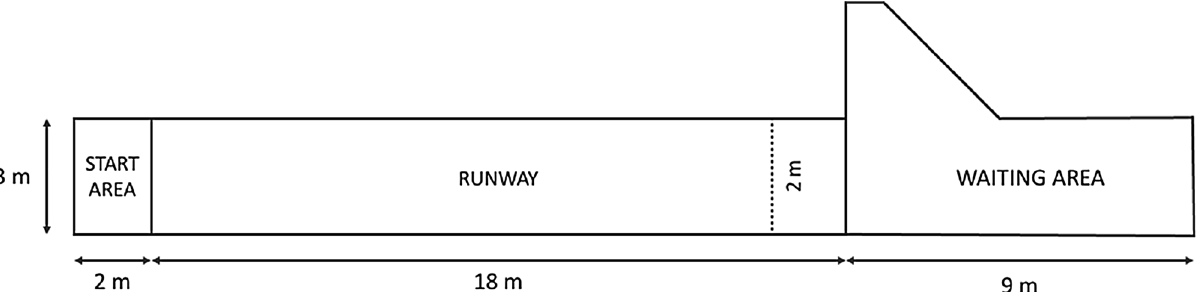
Figure 3. Layout of the runway. During the test, five cows were herded in the waiting area, and the focal heifer was brought by one experimenter to the start area. After 1 min, the heifer was released onto the runway for 5 min. A second experimenter scored the heifer’s time spent within 2 m (dashed line) from the gate separating the runway and the waiting being gently removed by the experimenter. The test lasted 5 min and started once the heifer voluntarily crossed the starting line with both front hooves. If the heifer did not cross the starting line within 5 min, the experi-